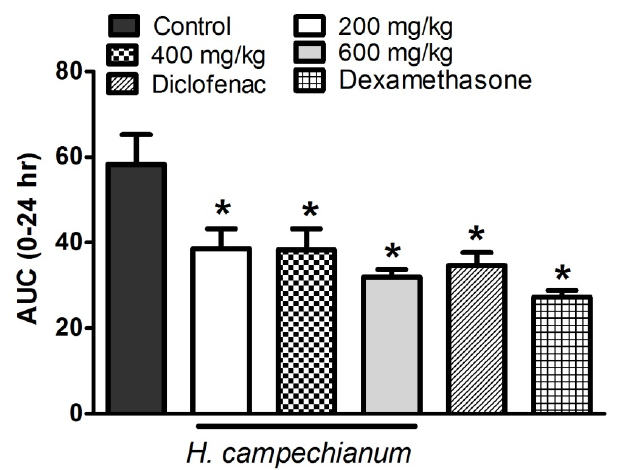
Figure 2. Effect of H. campechianum flower extract (p.o., 200, 400 and 600 mg/kg), diclofenac (p.o., 20 mg/kg) and dexamethasone (p.o., 2 mg/kg) on carrageenan (1%)-induced edema in paws of rats. Edema thickness was measured in mm before, hourly for 5 h, and finally at 24 h after carrageenan injection. Data shows the AUC0-24 and is expressed as mean values ± S.E.M (n = 5). * p < 0.05 vs. control values.